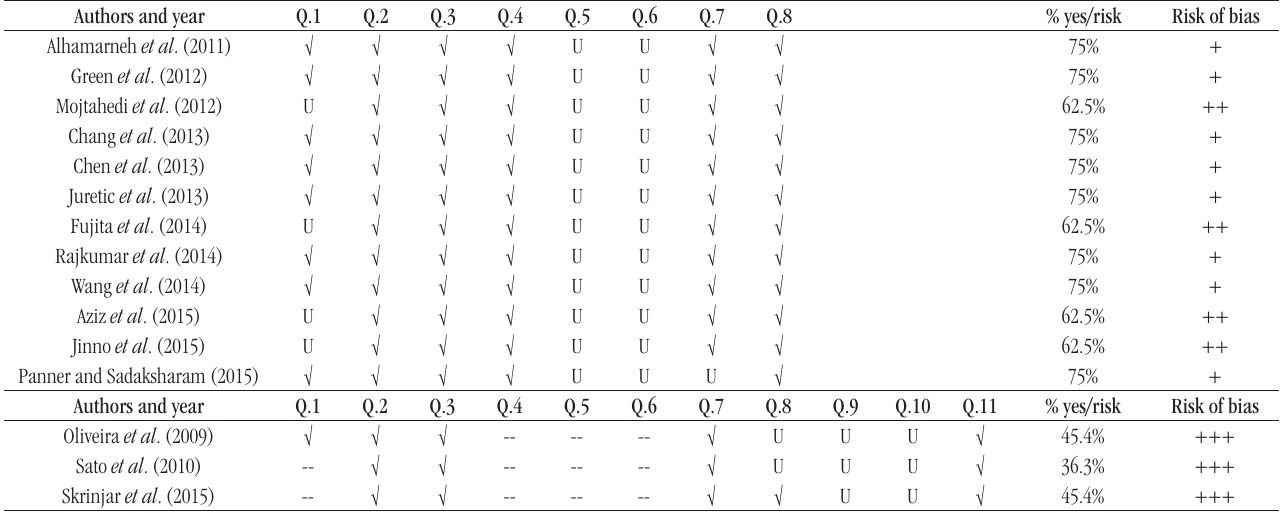
taBLE 3 − Risk of specific individual bias for each type of